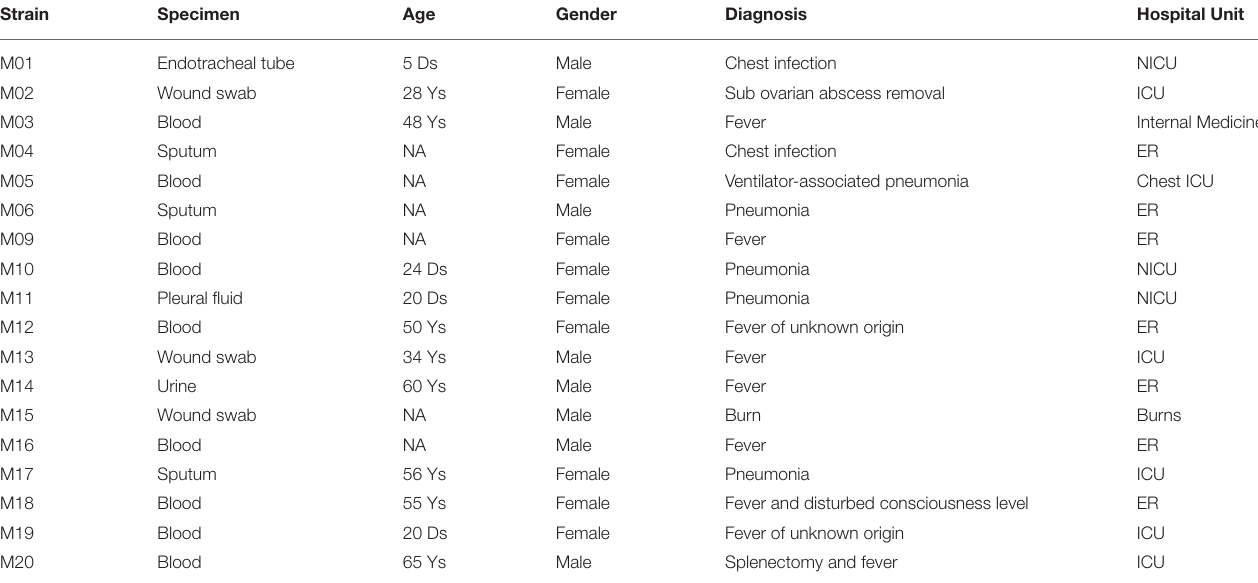
TABLE 1 | Demographic